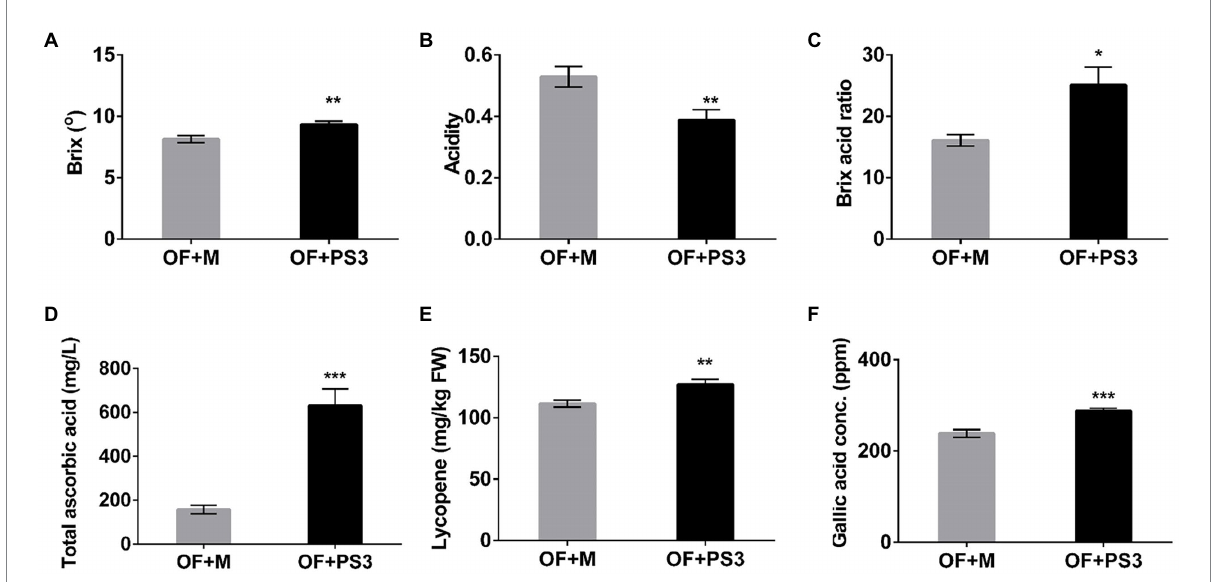
FIGURE 2 Effects of Rhodopseudomonas palustris strain PS3 on grafted tomato harvesting quality at the ripening stage. (A) Total soluble solids ( ° Brix). (B) Acidity. (C) Brix/acid ratio. (D) Total ascorbic acid (mg/L). (E) Lycopene contents (mg/kg FW). (F) Gallic acid concentration (equivalent to total phenolic content). All results are expressed as the mean ± SE. The statistical test was based on Welch’s t -test (*, p < 0.05; **, p < 0.01; and ***, p <